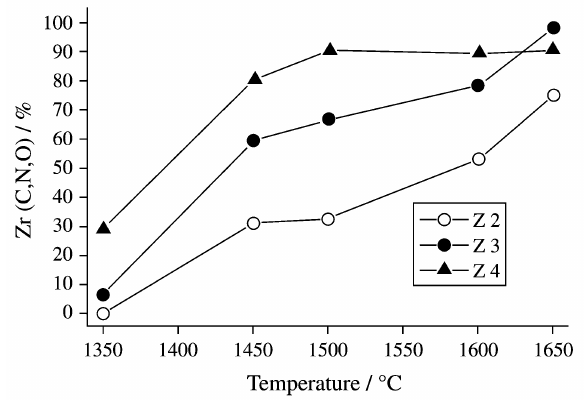
Figure 2. Evolution of the Zr(C,N,O) phase with temperature and carbon content. (Reaction time: 120 min).